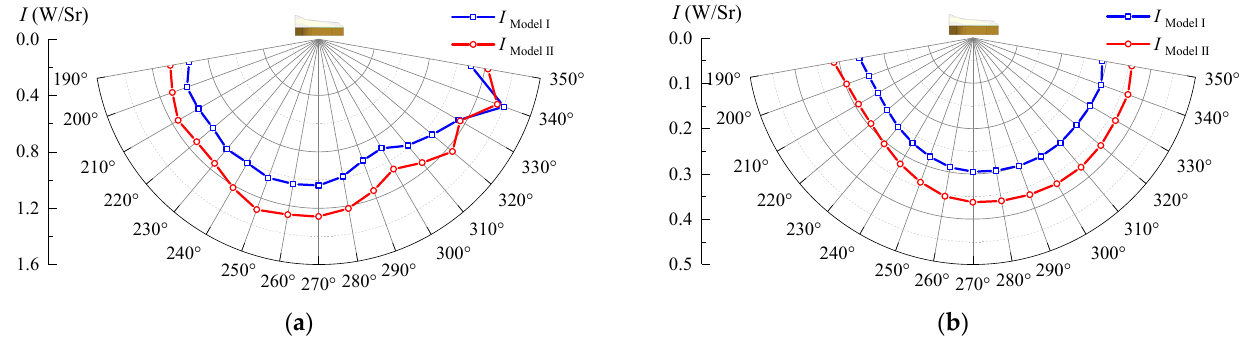
Figure 24. Infrared radiation intensity of exhaust plume. ( a ) 3–5 µm band; and ( b ) 8–14 µm band.